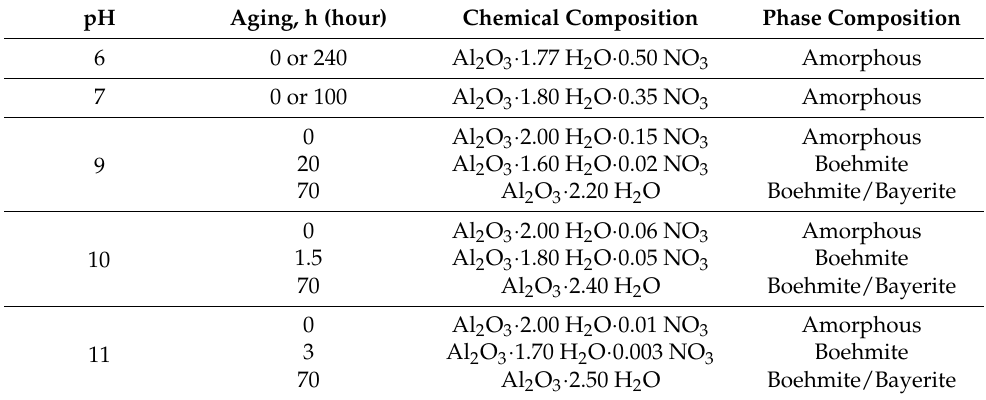
Table 2. Chemical and phase composition of aluminum hydroxides obtained under different precipi- tation conditions [15]. Copyright Springer Nature, 2021.